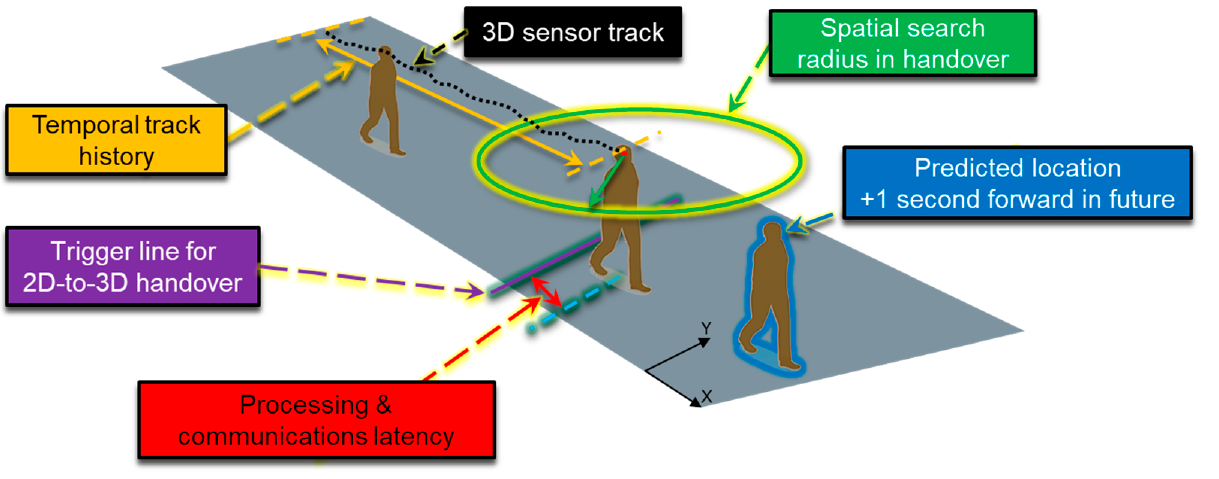
Figure 10. 3D Video handover principles, as in [7].